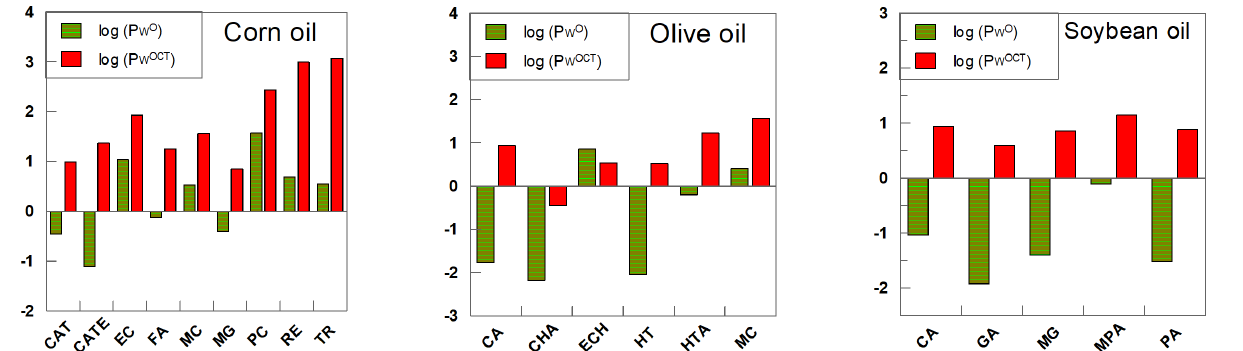
Figure 4. Comparison between the experimentally determined P WO values in oil–water systems [76] and the theoretical P WOCT values determined by employing the Molinspiration software (accessed on 23 February 2023) [74] for series of antioxidants with different molecular structures. CA: caffeic acid; CAT: catechol; CATE: catechin; CHA: chlorogenic acid; EC: ethyl caffeate; ECH: ethyl chlorogenate; FA: ferulic acid; GA: gallic acid; HT: hydroxytyrosol; HTA hydroxol acetate; MC: methyl caffeate; MG: methyl gallate; PA: protocatechuic acid; MPA: methyl protocatechuate; PC: propyl caffeate; RE: resveratrol; TR: trolox.